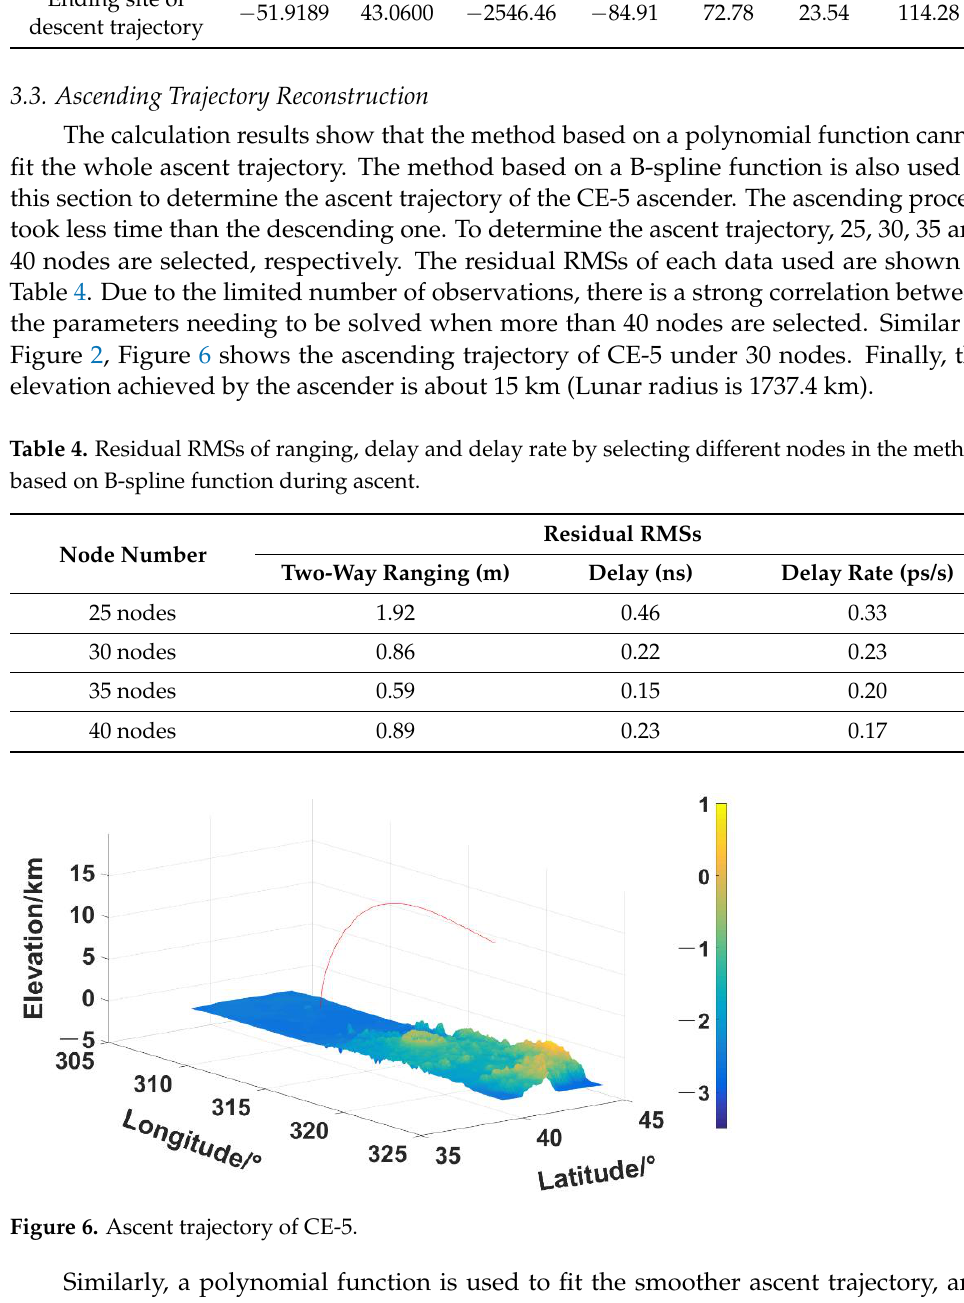
( b ) Figure 7. Elevation – time and velocity – time plots in CE-5 ’ s ascent trajectory: ( a ) shows elevation – time plot; ( b ) shows ve- locity – time plot. 4. Conclusions Sampling and return of extraterrestrial objects are CE- 5’s main task. Descent and as- cent trajectory determination using radiometric data reveals the phases that the lander and ascender experienced. Lander positioning provides initial states for the autonomous control during the lunar launch phase, and the positioning accuracy has an important im- pact on the subsequent phases. In this paper, the descent and ascent trajectories are determined by the method based on a B-spline function and a polynomial function. The results clearly reveal different